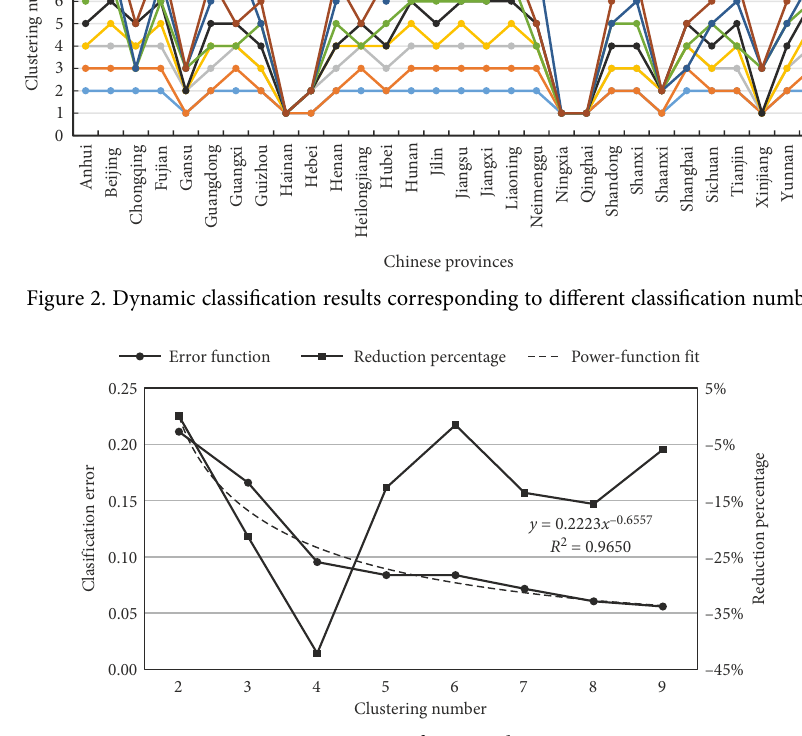
Figure 3. Error function diagram Table 3. Classification results of provinces for D =